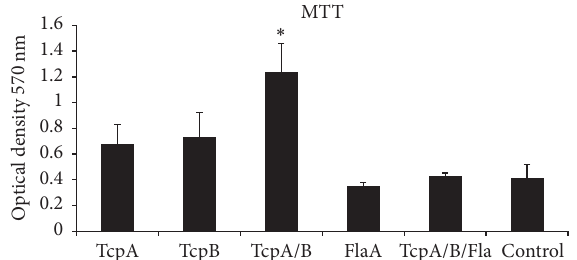
Figure 6: The MTT assay of the MNCs of BALB/c male immunized with specific recombinant proteins. Significant differences were designated as ∗ 𝑃 < 0.05